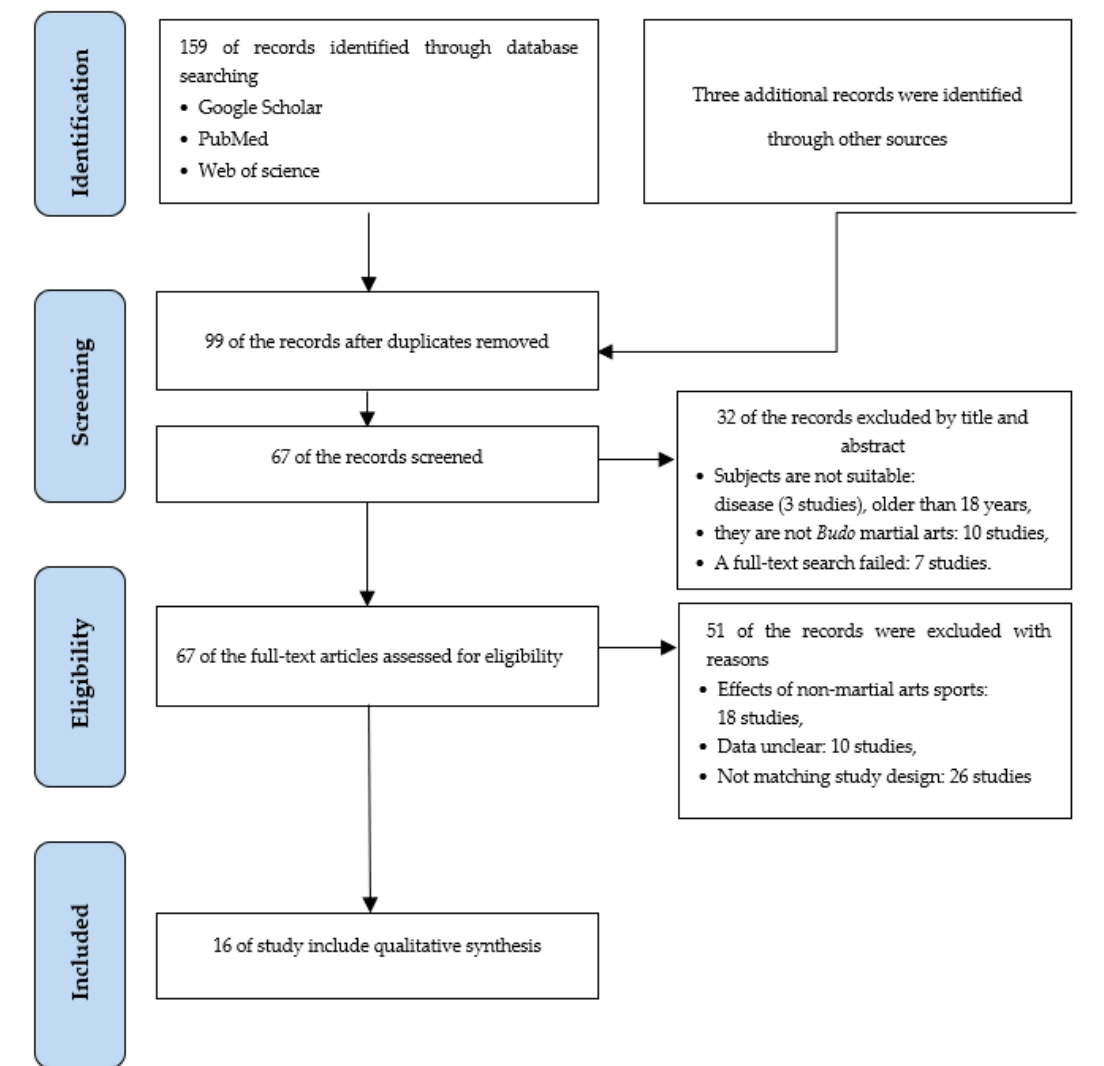
Figure 1. PRISMA flow diagram .